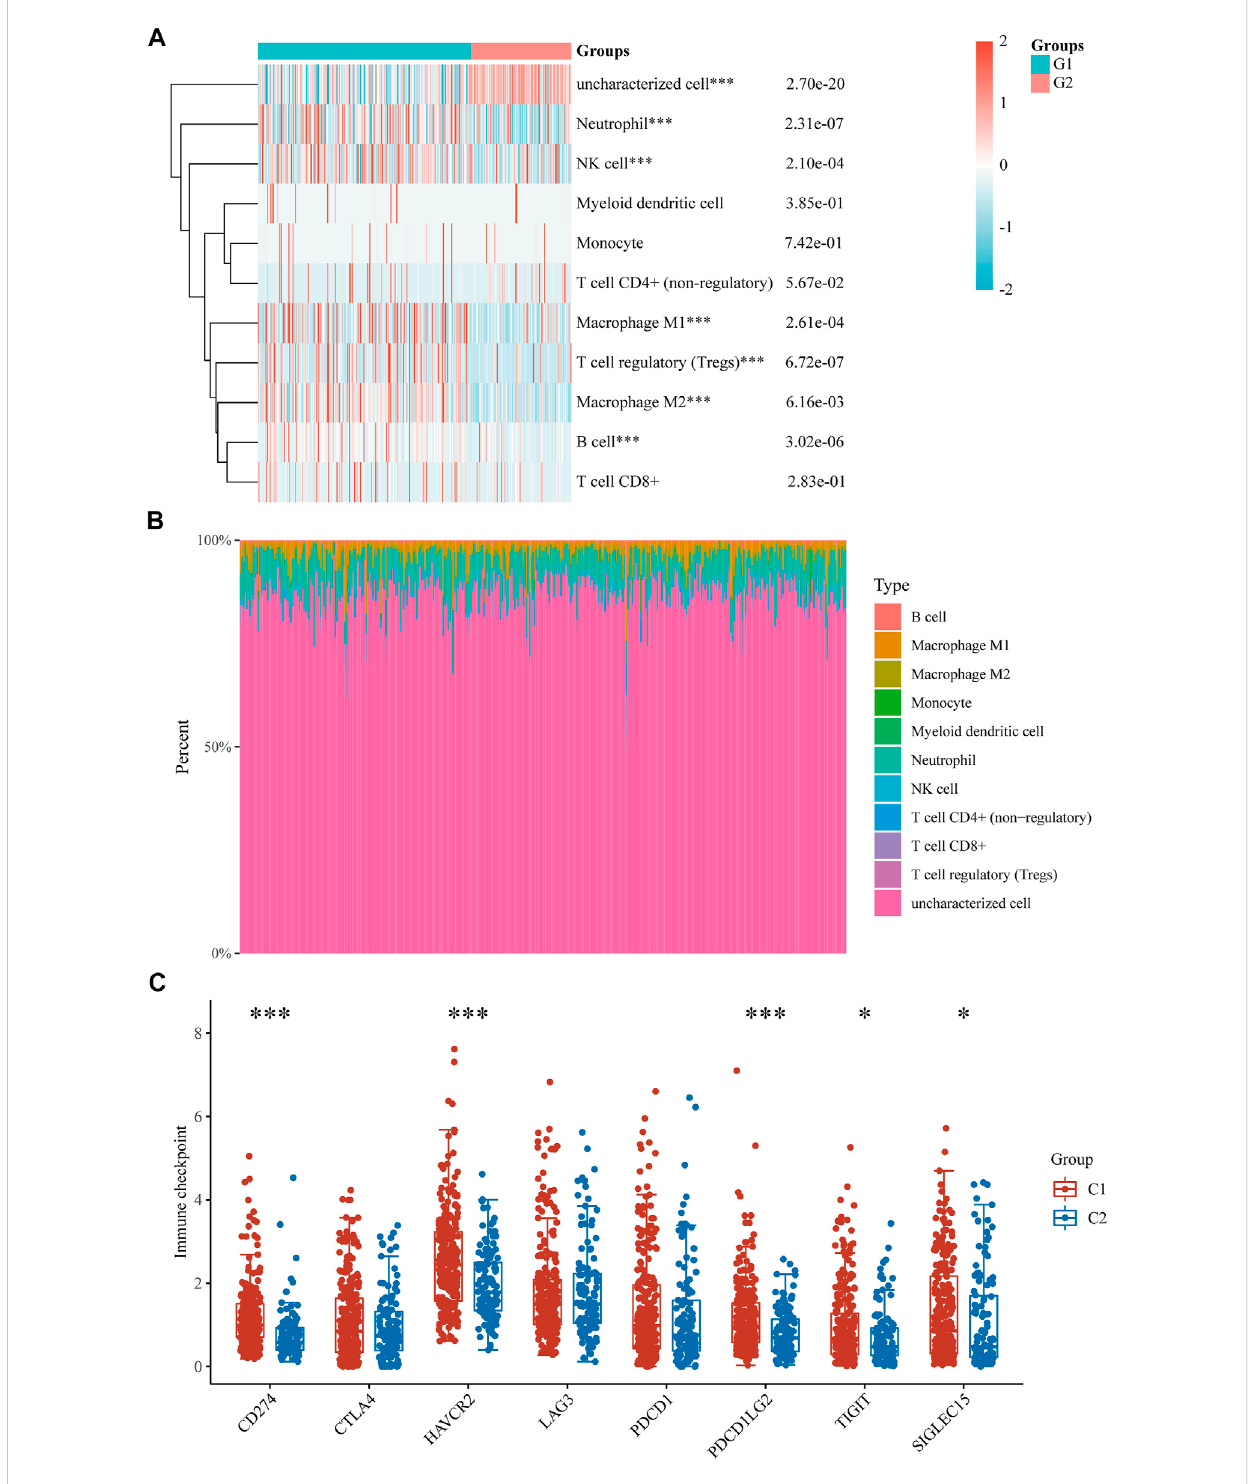
FIGURE 4 Immune in fi ltration estimated by quantTIseq algorithm and the expression distributions of 8 immune checkpoint-related genes in HCC subgroups. (A) Immunecellscore heatmap. (B) Proportions of11typesofimmunecells shownfor eachHCCpatientbyahistogram. (C) Theexpression distributions of 8 immune checkpoints-related genes in HCC subgroups. * p < 0.05; ** p < 0.01; *** p <